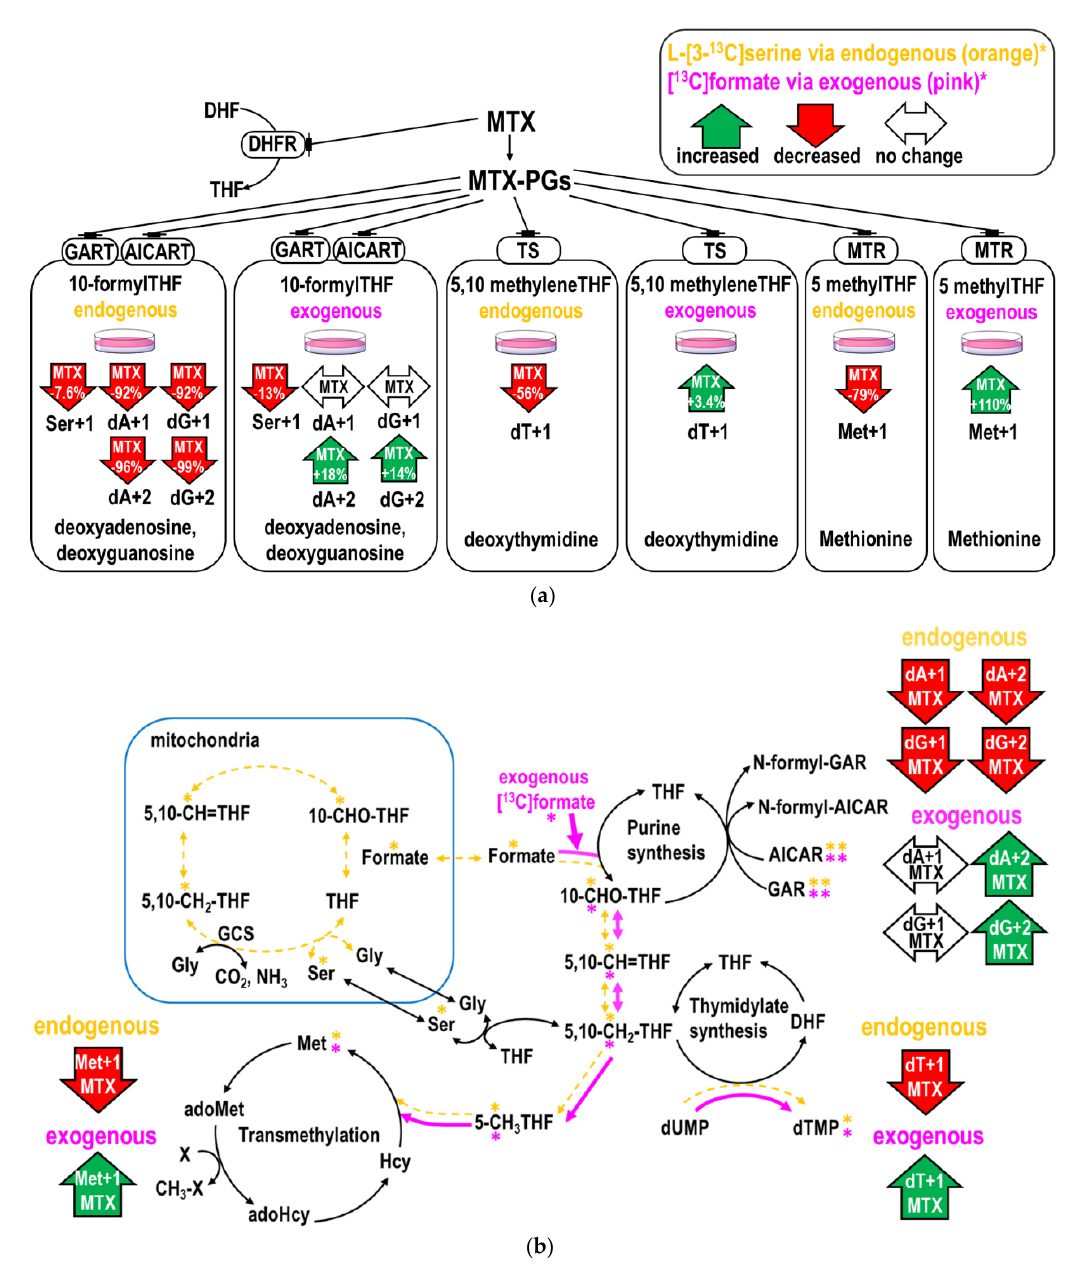
Figure 1. Effects of methotrexate (MTX) on endogenous and exogenous formate utilization. ( a ) The upper panel shows the percent changes of the enrichments in deoxyadenosine, deoxyguanosine, deoxythymidylate (dTMP), methionine, serine in cells treated with MTX. Endogenous and exogenous formate utilization were traced by L-[3- 13 C]serine (in orange) and exogenous [ 13 C]formate (in pink). MTX decreased the incorporations of 1C moiety from L-[3- 13 C]serine (endogenous formate) and increased that from exogenous [ 13 C]formate. The percent changes shown in the arrows indicate the isotopic enrichments in each target compound compared to controls. ( b ) The lower panel summarizes the metabolic fate of 1C flow from serine and formate. Solid arrows represent increased metabolic fluxes and dashed arrows represent decreased metabolic fluxes after MTX treatment.